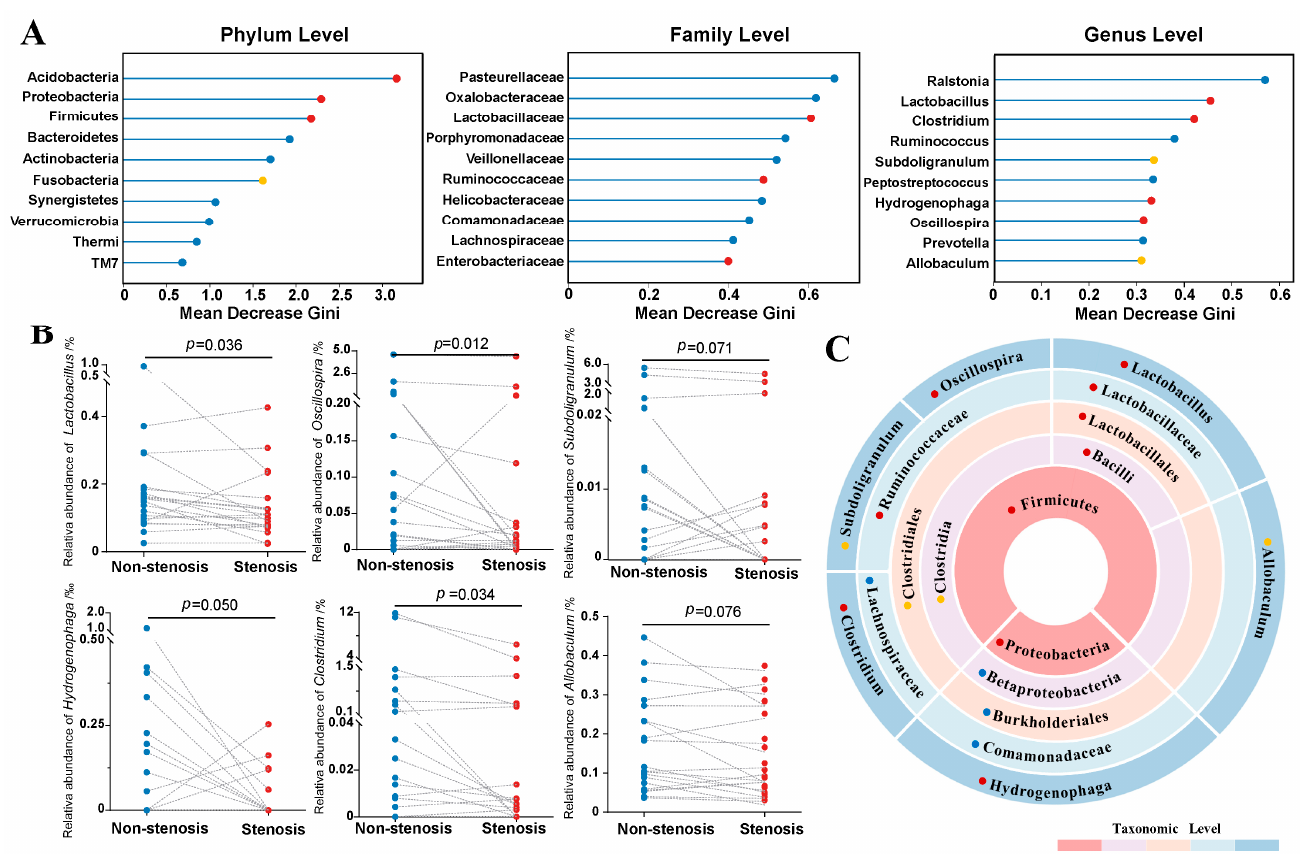
Figure 2. Taxonomic di ff erences between intestinal stenotic and non-stenotic sites in CD. ( A ): Random forest analysis to identify distinguishing microbes at di ff erent taxonomic levels. The x-axis presented the contribution of each taxon to the microbial heterogeneity between stenotic and non-stenotic sites (shown by the mean decrease Gini index when the corresponding taxon was removed from the analysis model). ( B ): Bacterial abundance alterations in di ff erent sites of every patient. ( C ): Biological relationship of distinguishing taxonomic levels. Statistical results of relative abundance variation between two sites for the corresponding taxon: ● p < 0.05; ● 0.05 < p < 0.1; ● p > 0.1.